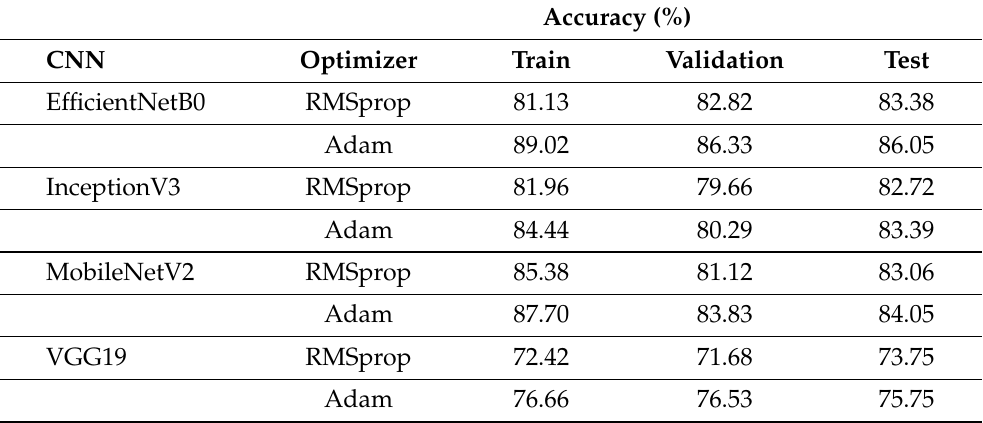
Table 4. Accuracy obtained on the training set, validation set and test set.